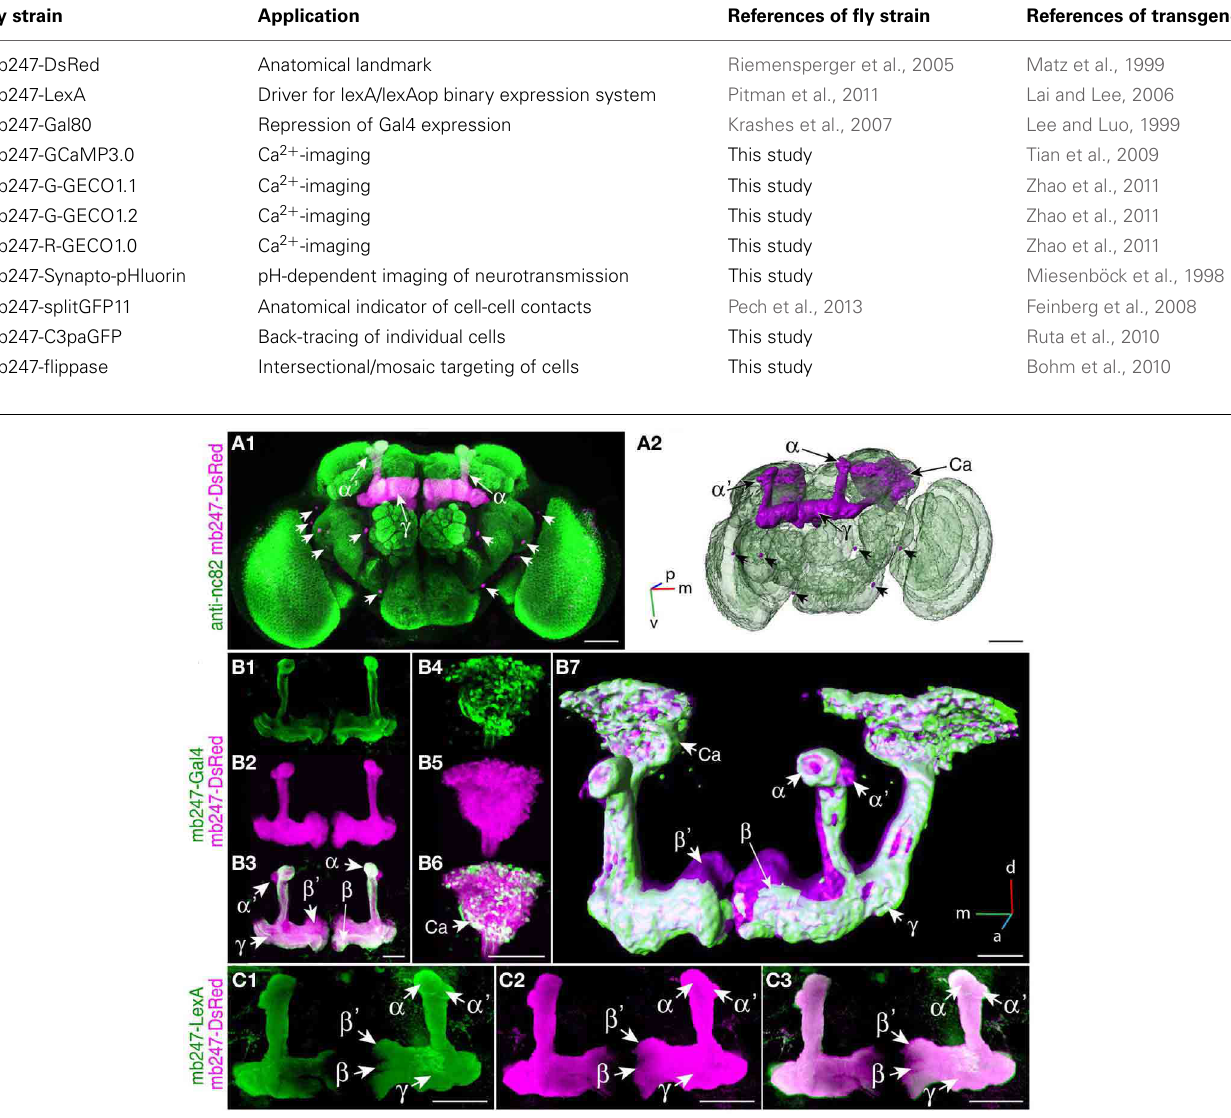
GFP expression shown in (B1) and DsRed expression shown in (B2) . (B4–B6) Mushroom body calyx showing expression of GFP driven by mb247-Gal4 (B4) , expression of DsRed driven by the mb247 promoter construct (B5) , and an overlay of both (B6) . (B7) 3D reconstruction of the brain depicted in (B1–B6) . (C) GFP expression induced by mb247-LexA::VP16 (Pitman et al., 2011) is visible in α / β − , α (cid:3) / β (cid:3) − , and lobes γ -lobes (C1) . (C2) DsRed expression under control of the mb247 promoter. (C3) Overlay of (C1) and (C2) . Scale bars = 50 μ m in (A,B) , and 100 μ m in (C) . Ca, calyx ; α , α -lobe; α (cid:3) , α (cid:3) -lobe; β , β -lobe; β (cid:3) , β (cid:3) -lobe; γ , γ -lobe; p, posterior; m, medial; v,